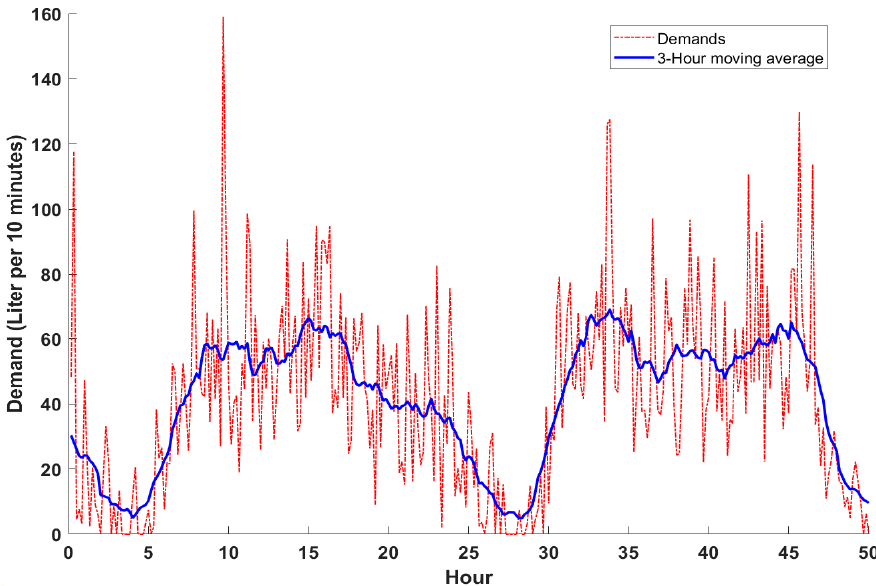
Figure 3. Two days of toilet flushing demands for 40 apartments created by the stochastic water demand generator. Demands as liter for 10 min (dashed red) show erratic pattern, 3-h moving average reveal typical diurnal pattern.